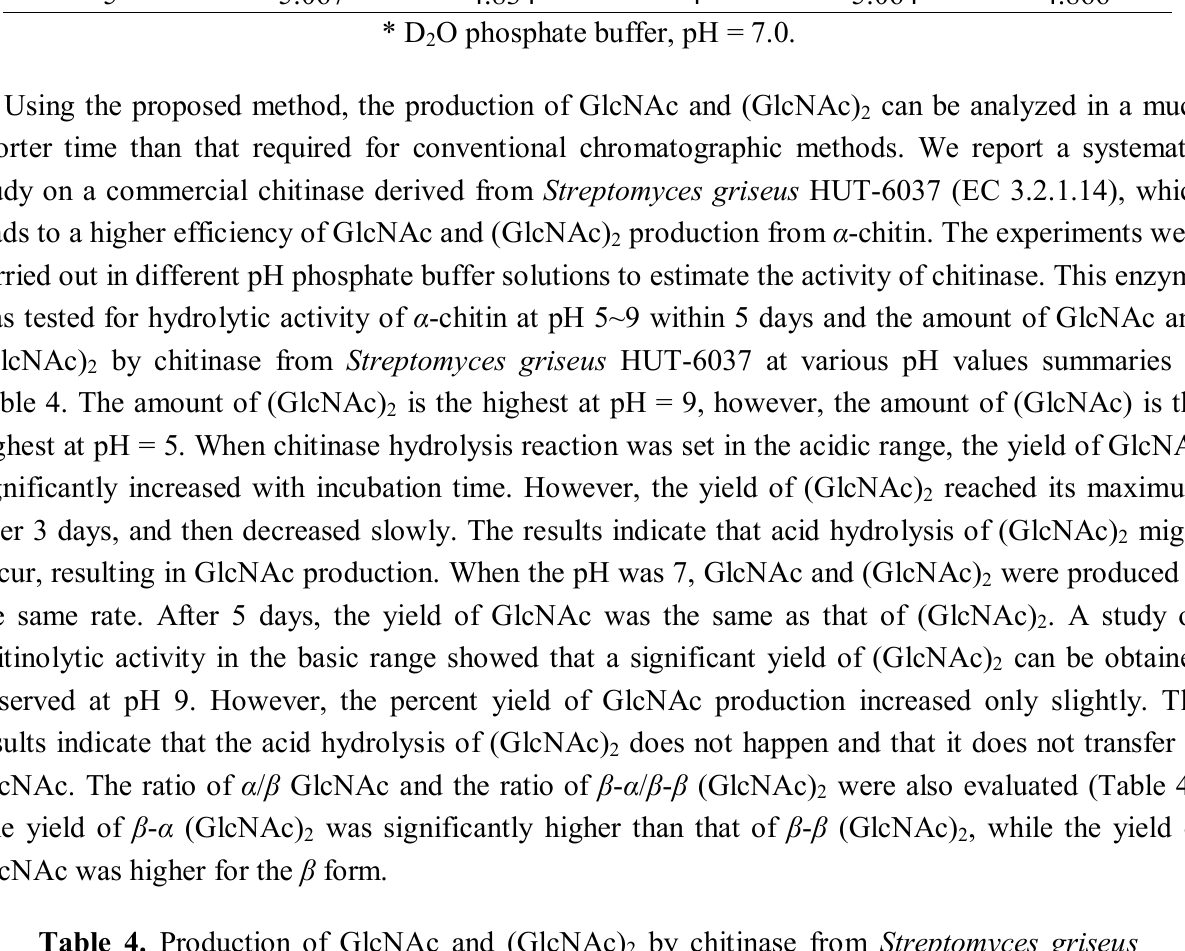
Table 4. Production of GlcNAc and (GlcNAc)